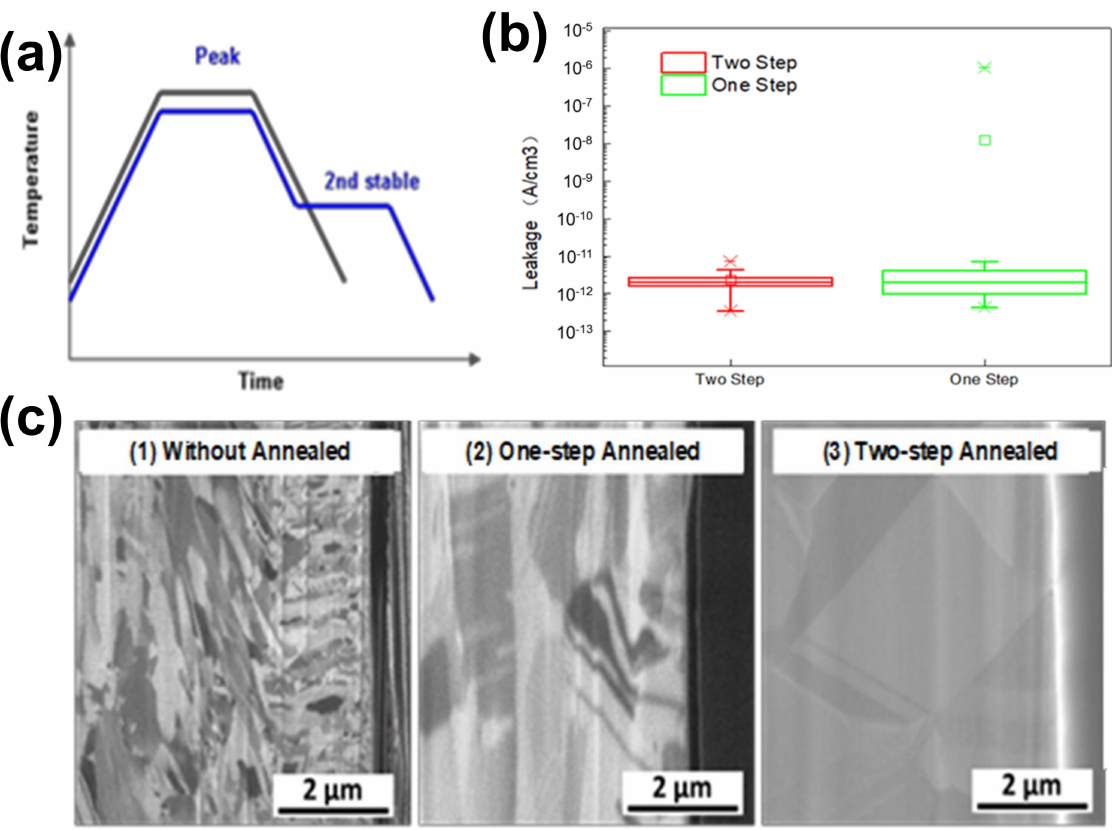
Figure 9. ( a ) Temperature profile curves of the two types of annealing processes. ( b ) Leakage performance of the Cu-filled TSV with two-step annealing and one-step annealing processes. ( c ) SEM images showing the cross-section of the Cu-filled TSV samples without annealing, with one-step annealing and two-step